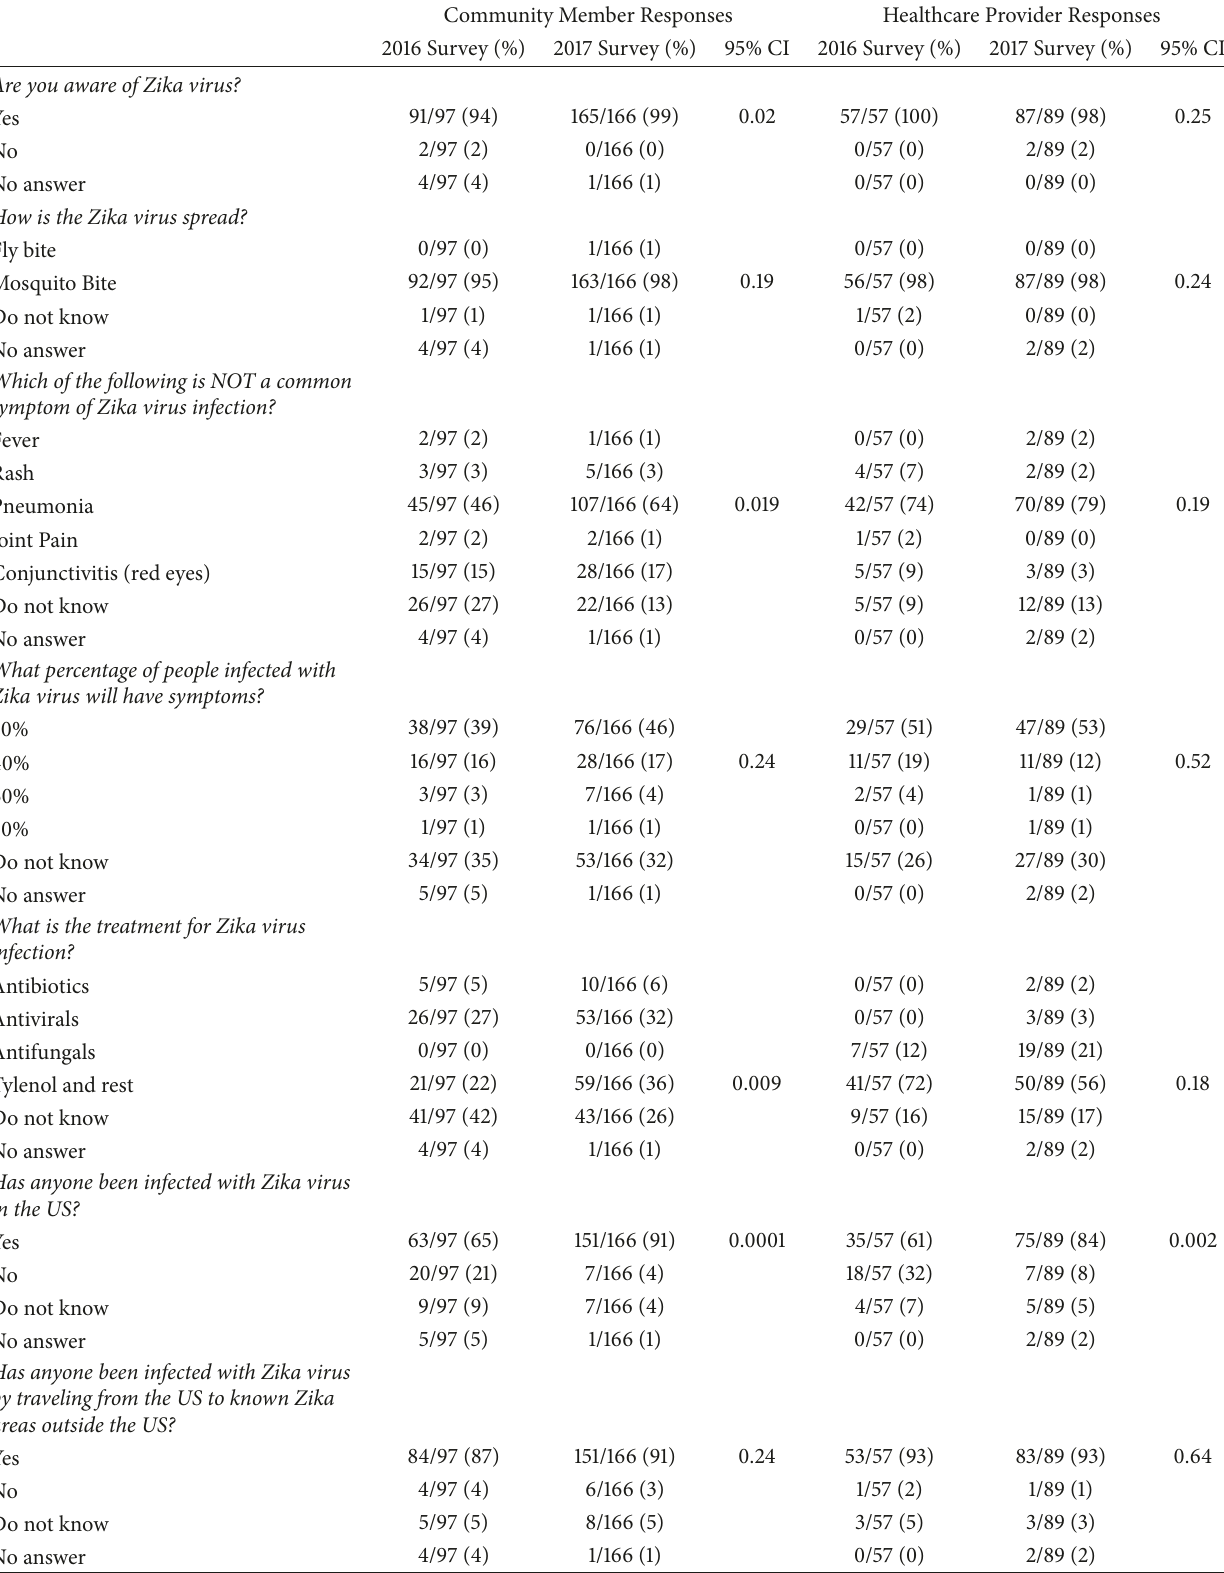
Table 2: Responses to “knowledge” questions regarding Zika virus disease and